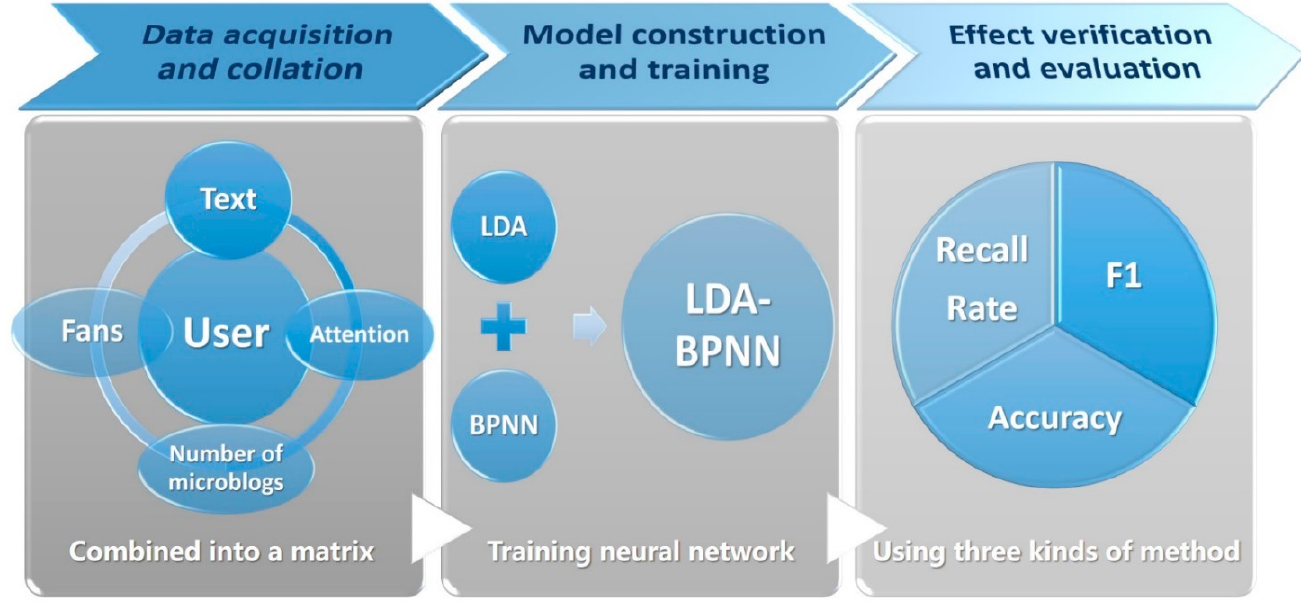
Figure 1. Flowchart of user OCEAN (Openness, Conscientiousness, Extraversion, Agreeableness, and Neuroticism) personality model prediction based on BP neural network.